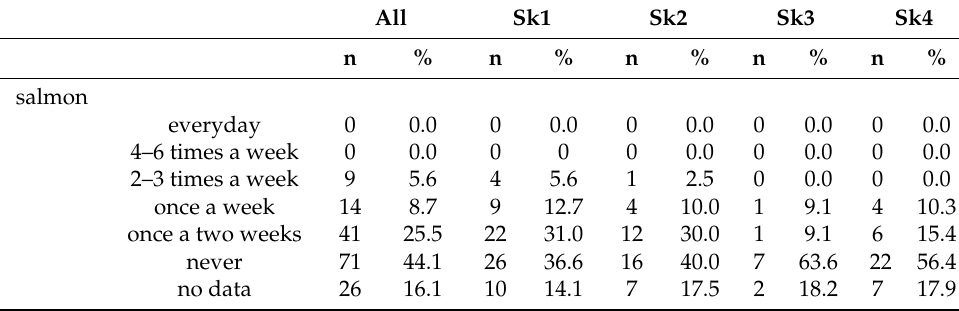
Table A4. Fish consumption among investigated